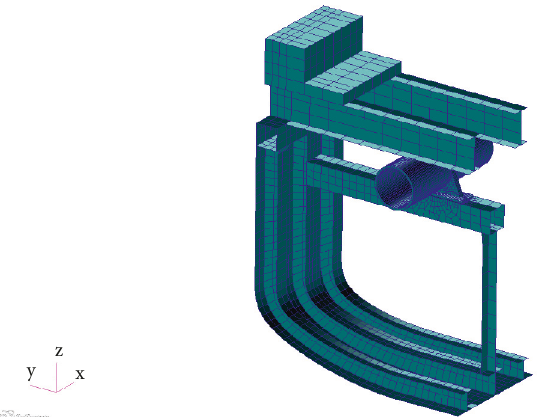
Figure 11: Connection simulation of the backbone to the hull. Table 4: Comparison of predicted dry and wet natural frequencies in the full load condition.